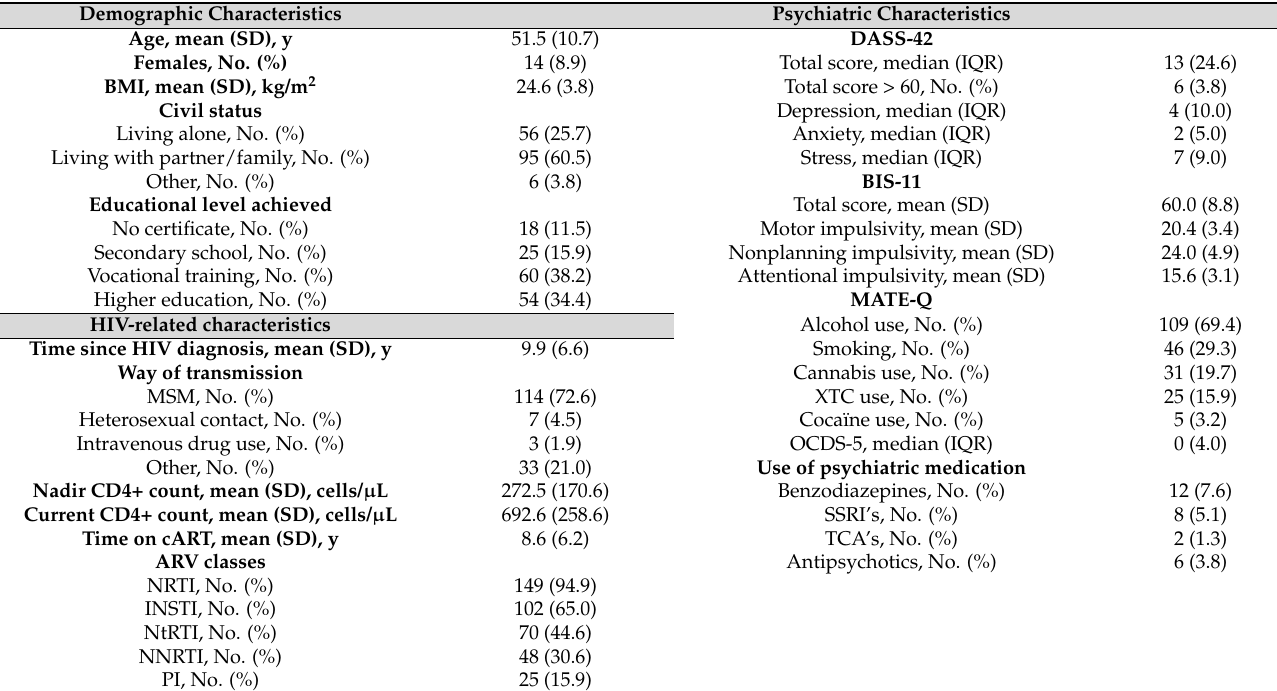
Table 1. Patient characteristics ( n = 157).